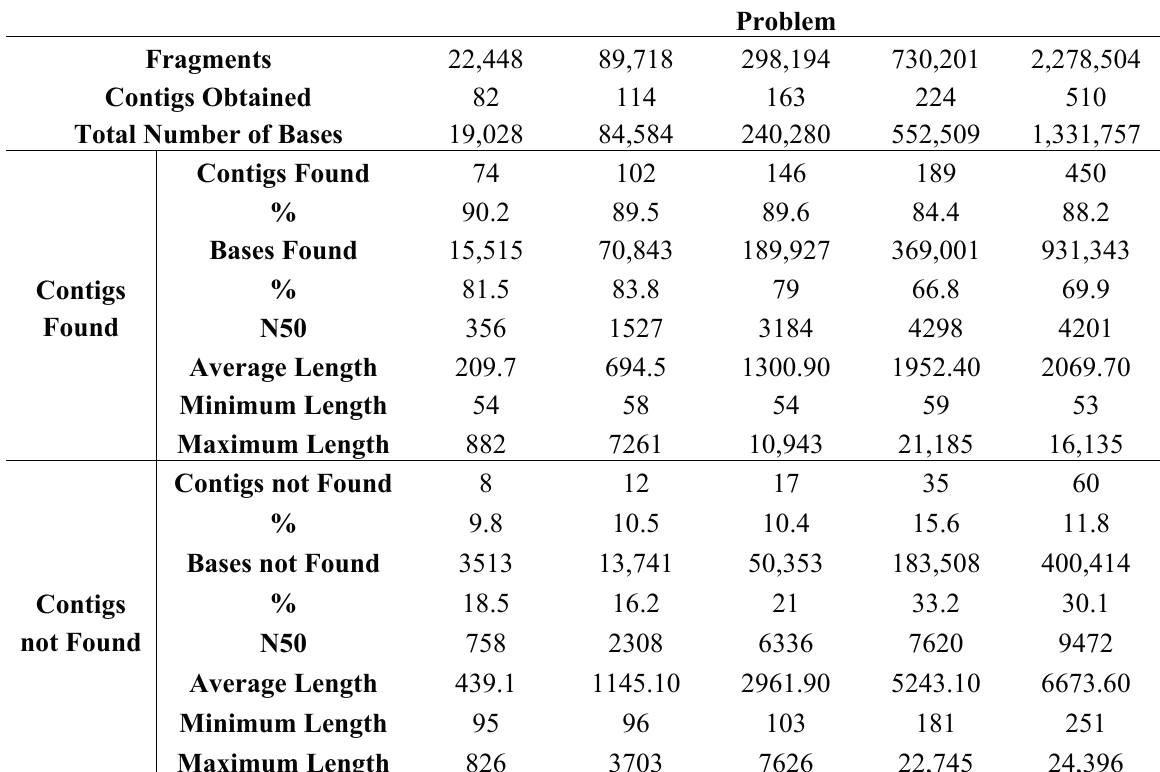
Table 7. Algorithm 1, F 2 objective function, all